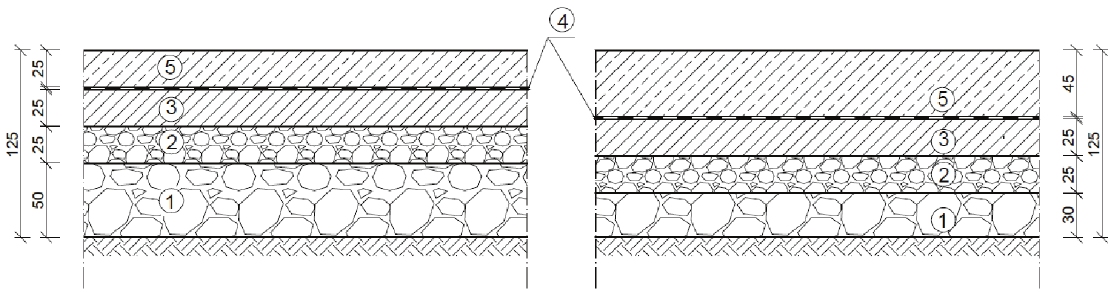
Fig. 2. Fragments of runway cross-section, (a) in prestressed technology, variant